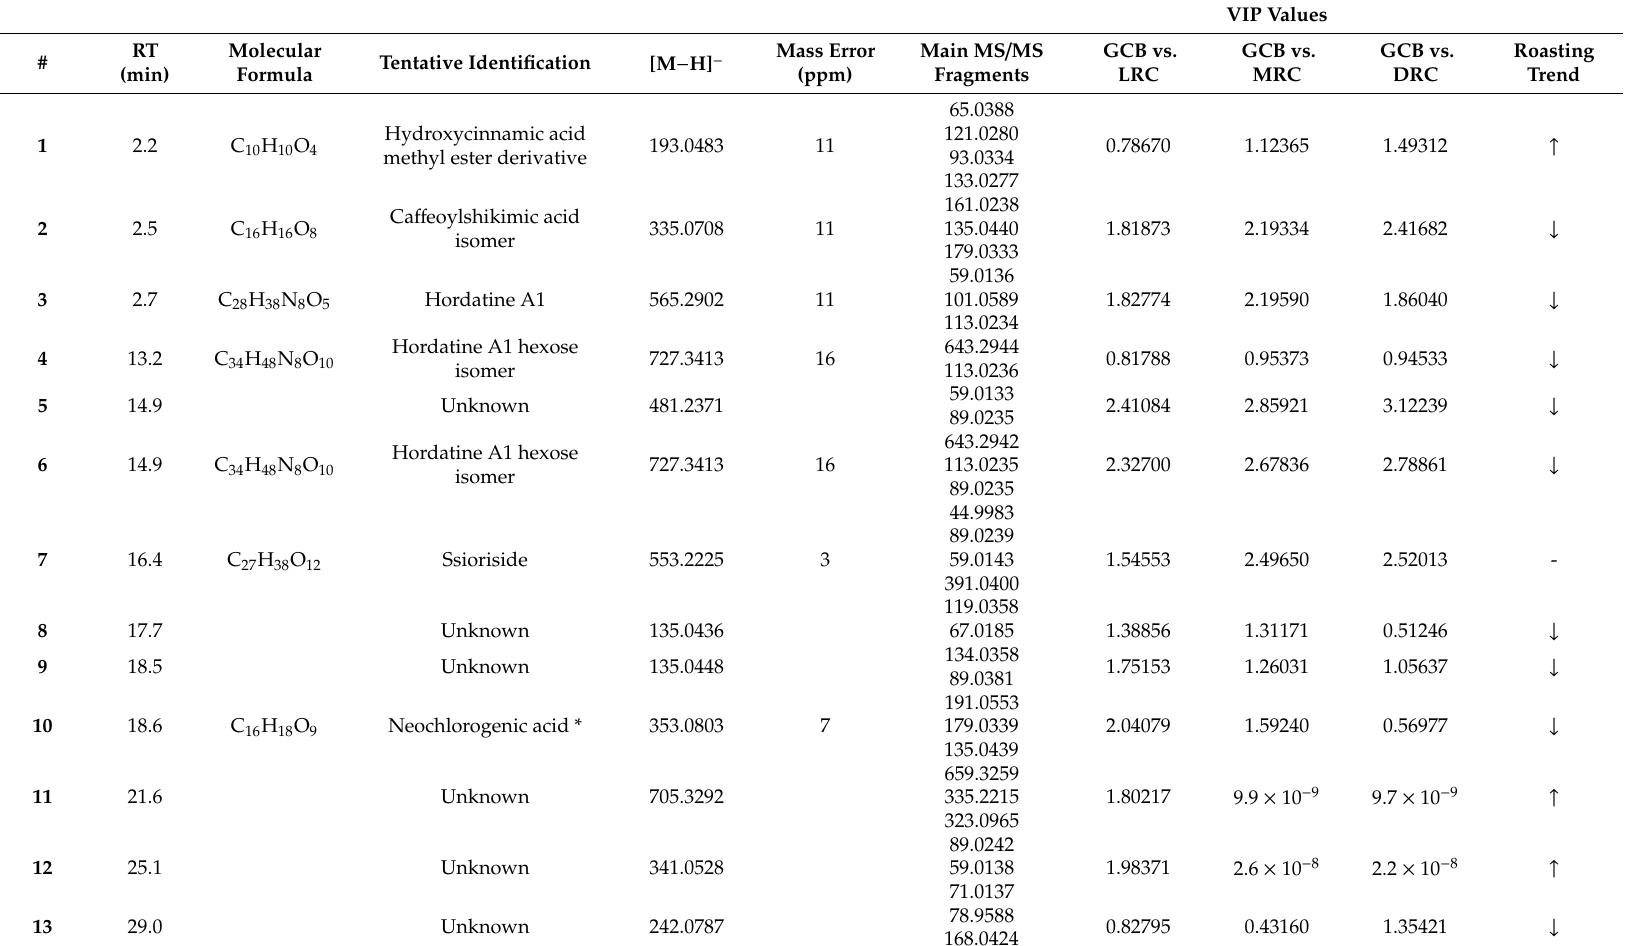
Table 2. MS / MS fragmentation of potential markers of co ff ee roasting process in negative ionization mode.